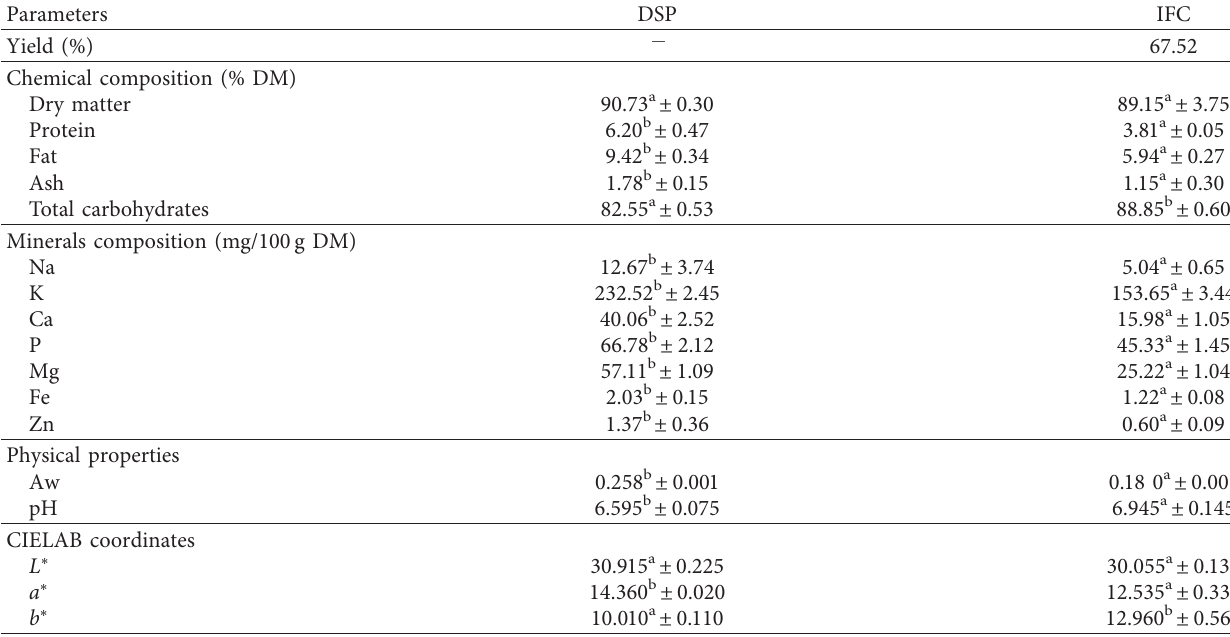
Table 2: Physicochemical and technofunctional properties of DSP and IFC.